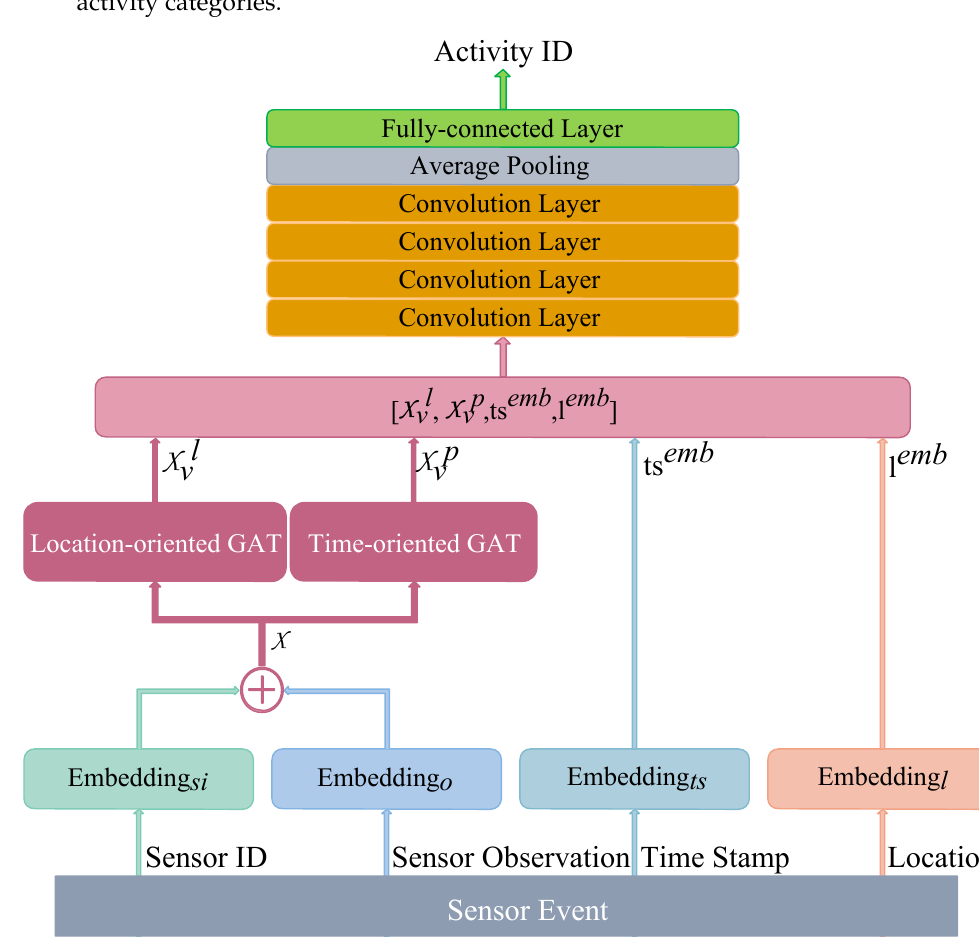
Figure 6. The overall network architecture of the proposed